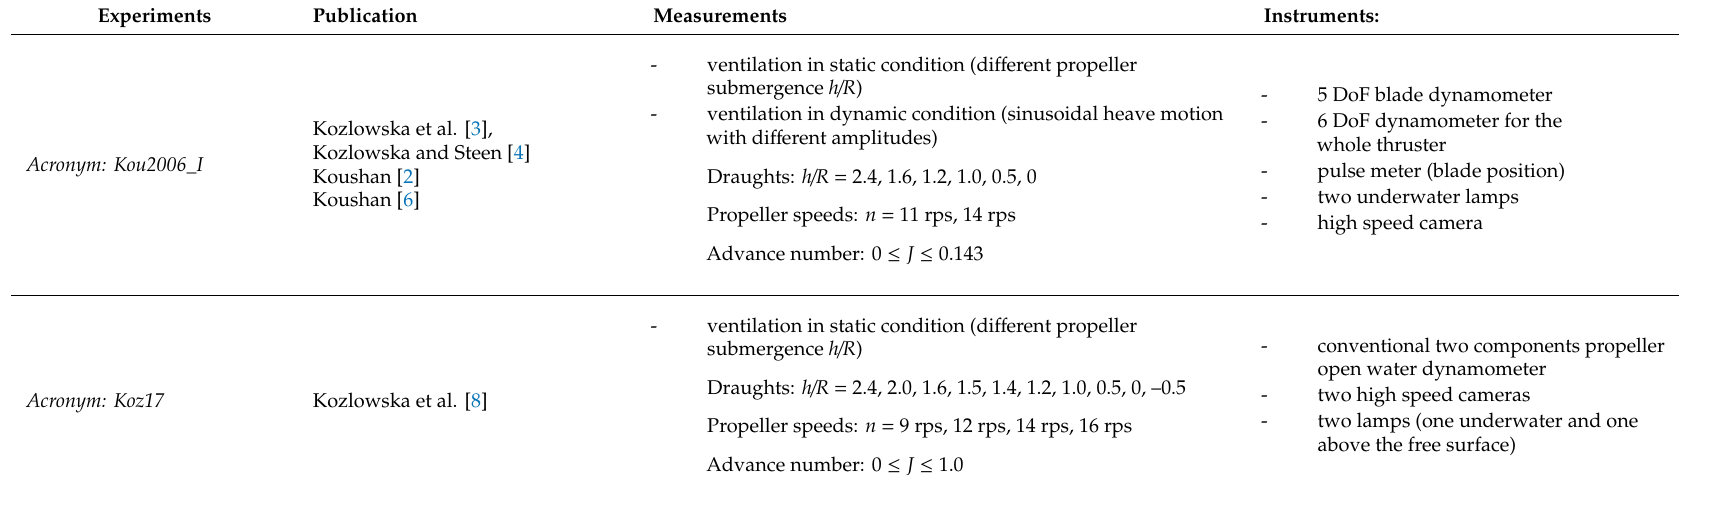
Table 1. Summary of performed test campaigns presented in this